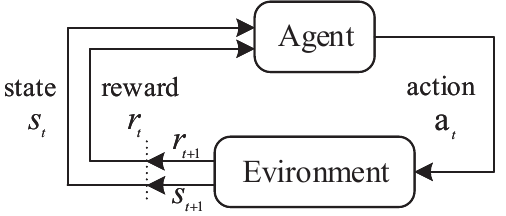
Figure 4. The basic structure of reinforcement learning.